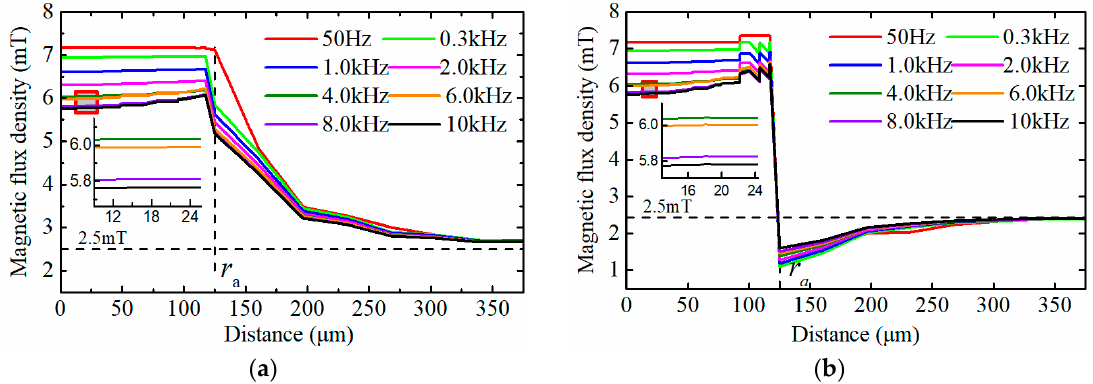
Figure 6. The distribution of the equivalent magnetic flux density under different effective field frequencies ( a ) The distribution of the equivalent magnetic flux density along the x axis; ( b ) The distribution of the equivalent magnetic flux density along the y or z axis.